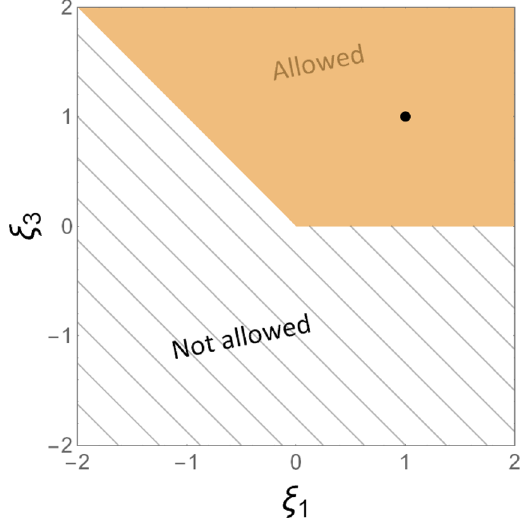
Figure 3 . Bounds on (4-d) operators coefficients for N f = 2 . Plot showing in yellow the allowed parameter space for ξ d,i and ξ d,i , i = 1 , 2 . The black dot indicates the natural MFV benchmark 1 3 point, ξ = 1 , that can be seen being inside the allowed 1 , 3